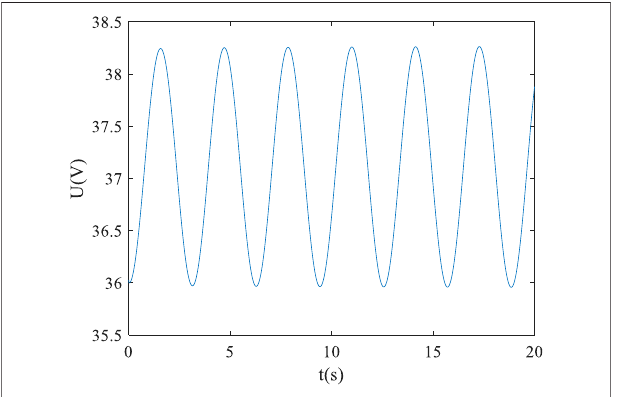
FIGURE 4 | U-t curve of the photovoltaic cell. FIGURE 5 | P-t curve of the photovoltaic